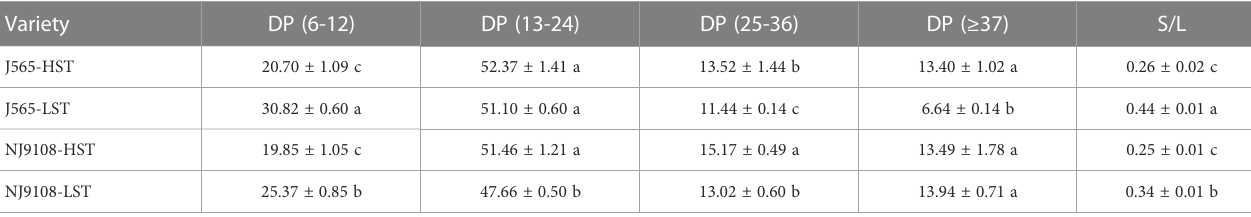
TABLE 3 Branch-chain length distributions of debranched amylopectin of starch in the two growth seasons. Variety